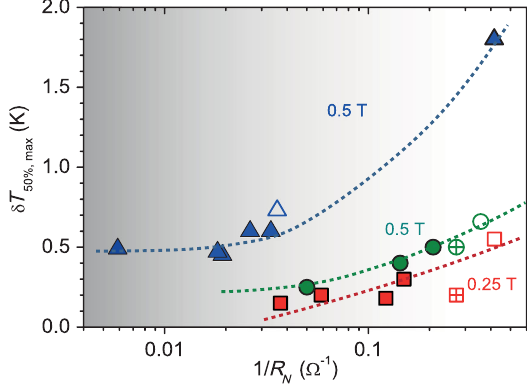
FIG. 4. Dependence of TSV effect on interface transparency. Variation of T 50% ; plotted against the inverse of the normal max state resistance R N (interface transparency), for spin valve devices with different interfaces between the CrO 2 layer and the MoGe = Ni = Cu stack. Blue triangles: TSV25 ( d S ¼ 25 nm), measured at 0.5 T; open symbol: TSV25a. Green circles (red squares): TSV50 ( d S ¼ 50 nm), measured at 0.5 T (0.25 T). Symbols with þ are device TSV50a, the open green circle (red square) is